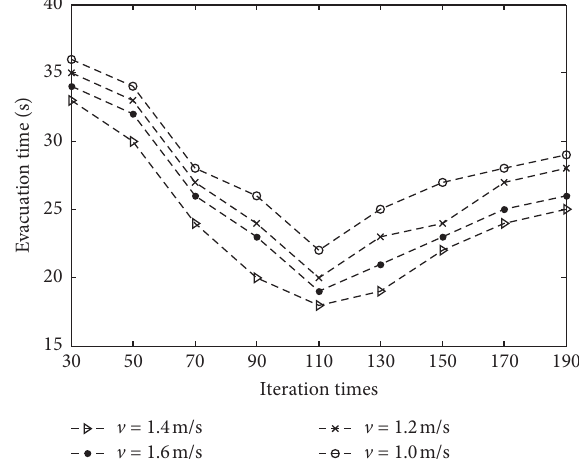
Figure 6: The change between the evacuation time and the number of iterations at different expected